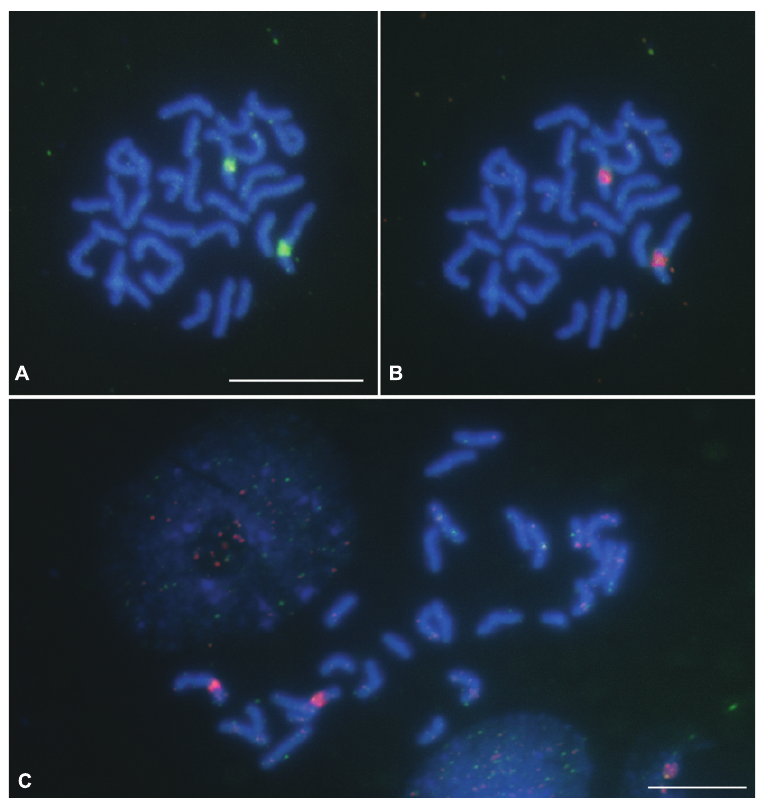
Fig. 4, A-C. FISH in H. magnipapillata mitotic chromosomes with 18S and 28S rDNA probes. Signals are visible in the largest chromosome pair. Chromosomes hybridized with 18S rDNA probe (green signals) ( A ) and 28S rDNA probe (red signals) ( B ); chromosomes hybridized with BAC probe (clone 16C18) containing 18S rDNA repeats (red signals) ( C) . Chromosomes are counterstained blue with DAPI. Bars = 10